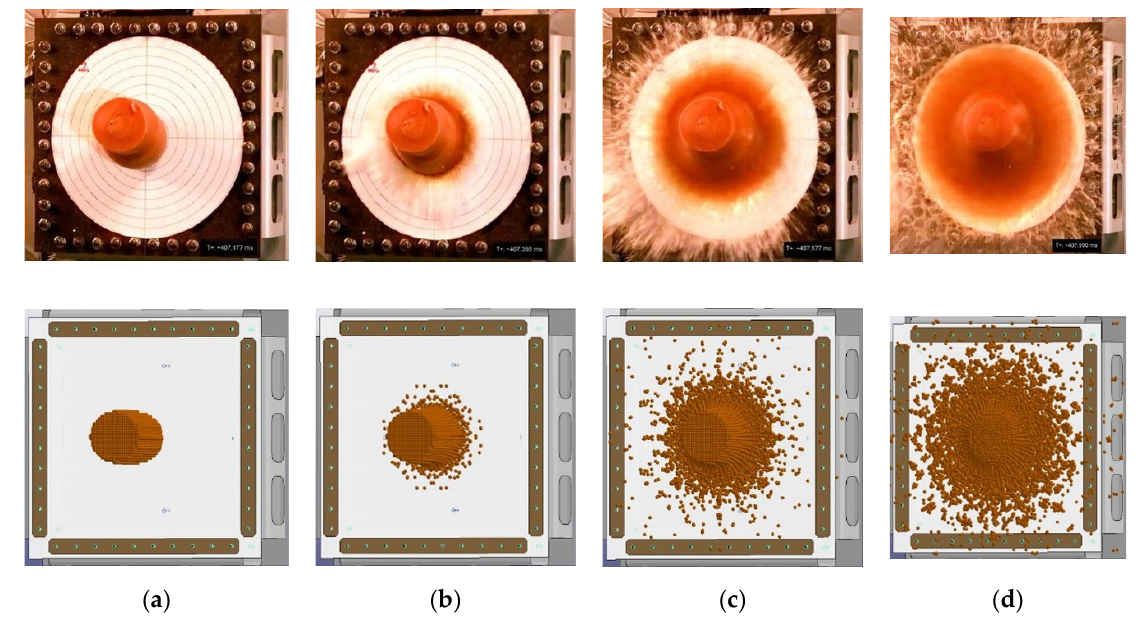
Figure 30. Comparison of the projectile deformation for experimental and numerical studies: ( a ) 0 ms; ( b ) 0.3 ms; ( c ) 0.8 ms ( d ) 1.2 ms. ( b ) 0.3 ms; ( c ) 0.8 ms ( d ) 1.2 ms.